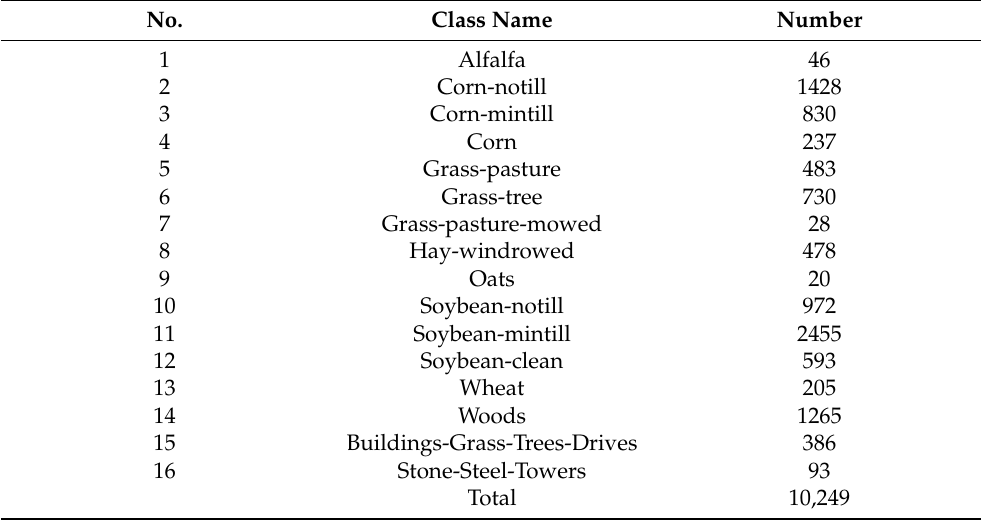
Table 1. Information on the number of samples per category in the IP dataset.